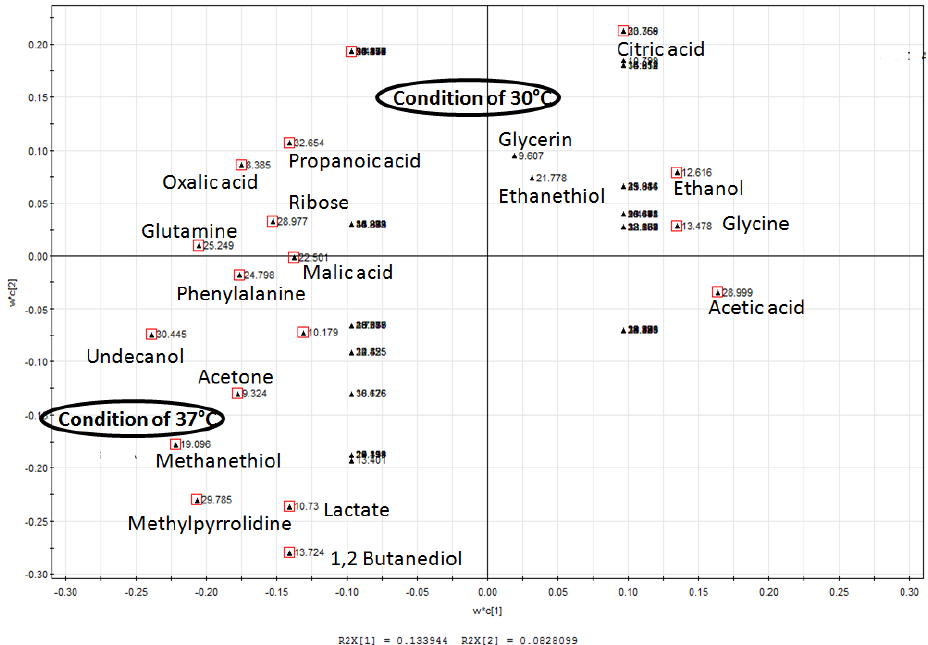
Figure 2. PLS-DA derived loading plot analysis of metabolites profiles. PLS-DA analysis with temperature as the y variable was used to identify the metabolites that distinguished L. lactis grown in non-agitated condition of 30 °C and 37 °C. Compounds marked red indicate metabolites with variable importance for projection (VIP) values exceeding